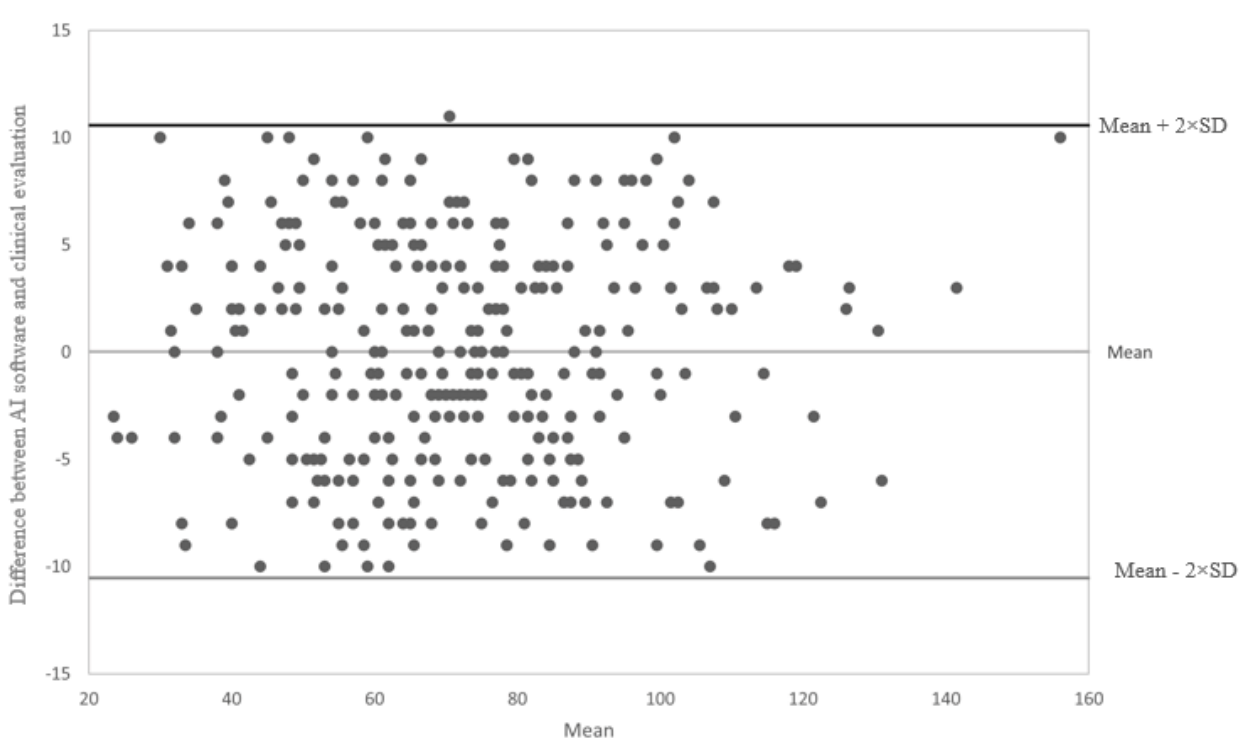
Figure 3. Bland–Altman plot analysis comparing the number of hyperreflective foci (HRF) assessed by artificial intelligence (AI) software and clinical evaluation. AI: artificial intelligence; SD: standard deviation.